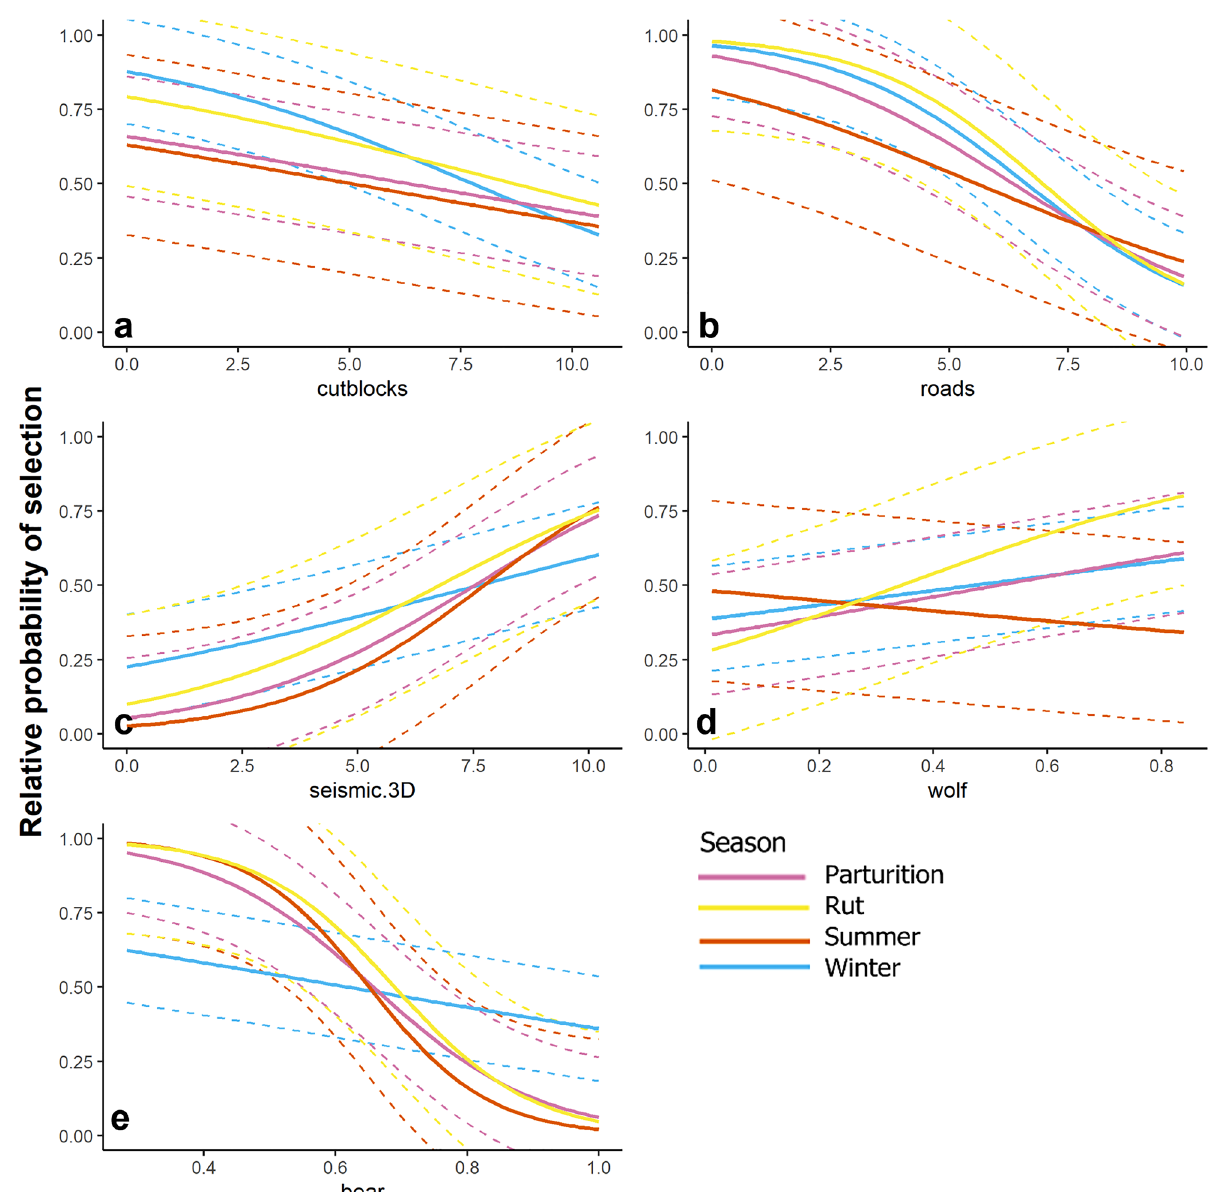
Figure 3. Population-level relative probability of selection (mean and 95% confidence intervals) for white-tailed deer in northeastern Alberta as a function of ( a ) log-transformed distance to cutblocks, ( b ) log-transformed distance to roads, ( c ) log-transformed distance to 3D seismic lines and ( d ) relative probability of wolf occurrence and ( e ) relative probability of black bear occurrence. Confidence intervals incorporate error from the random effect of